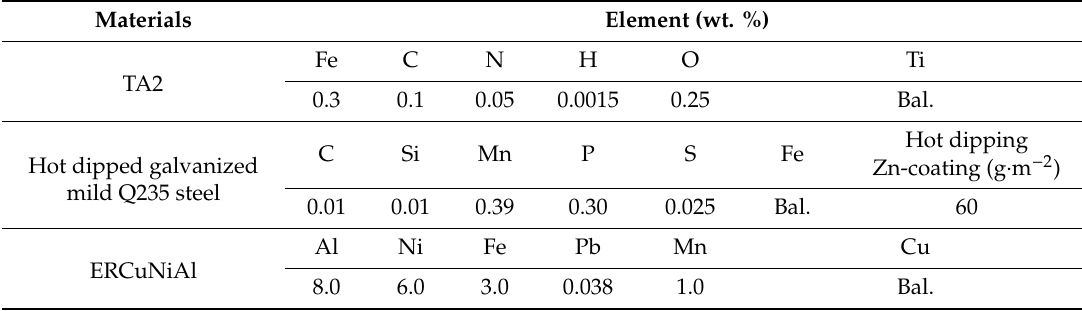
Table 2. Nominal chemical compositions of TA2 sheet, hot dipped galvanized mild Q235 steel sheet and ERCuNiAl copper-based wire.